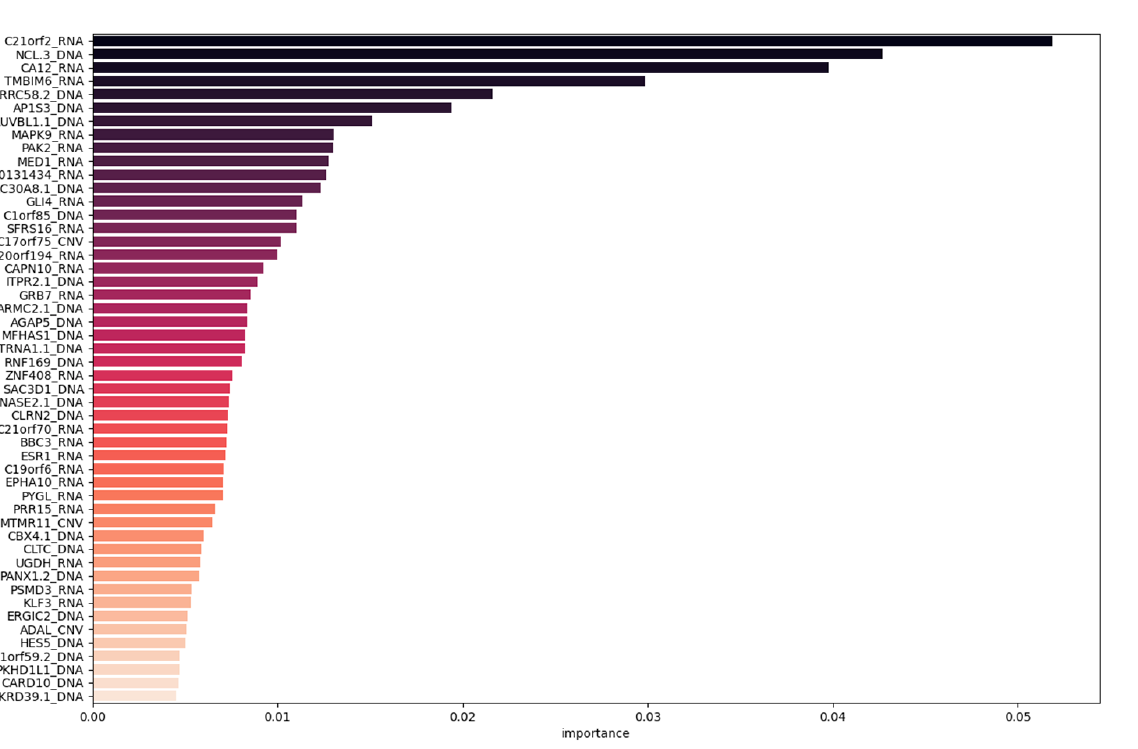
Figure 2. Baseline Results Summary.